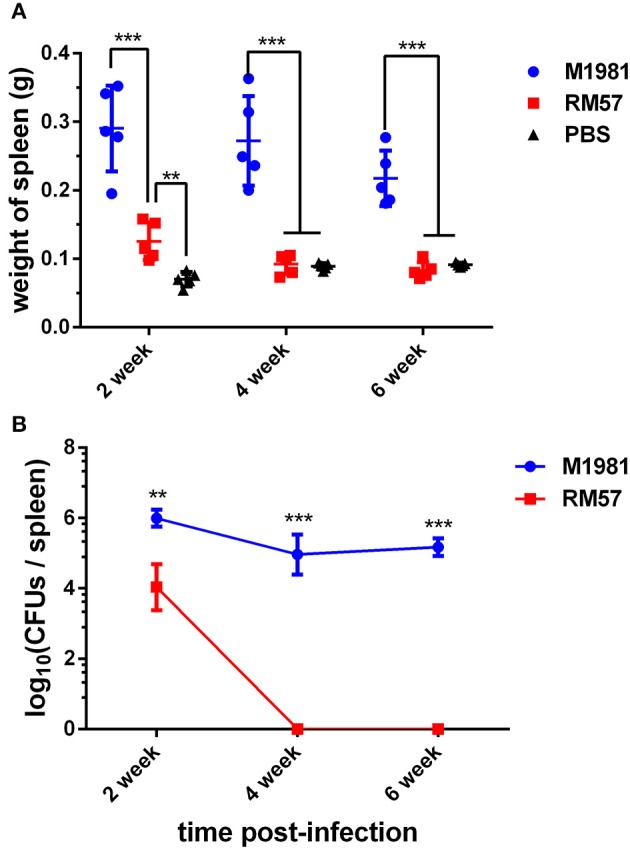
Virulence of RM57 attenuation in mice infection models. (A) Spleen weight of RM57 and M1981 infected mice at 2, 4, and 6 weeks post infection. (B) Splenic CFUs of RM57 and M1981 infected mice at 2, 4, and 6 weeks post infection. Values represent the means of spleen weight or splenic CFUs at each time point, and the error bars indicate the standard deviation (SD) of the mean. *p < 0.01 and ***p < 0.001.